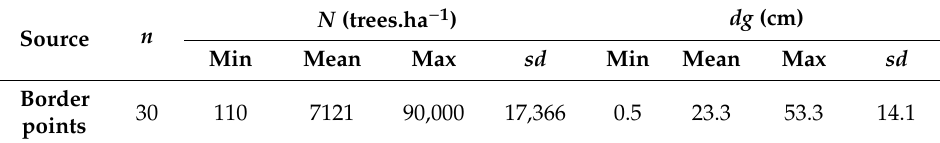
Table 2. Summary characteristics of the data used in the self-thinning line